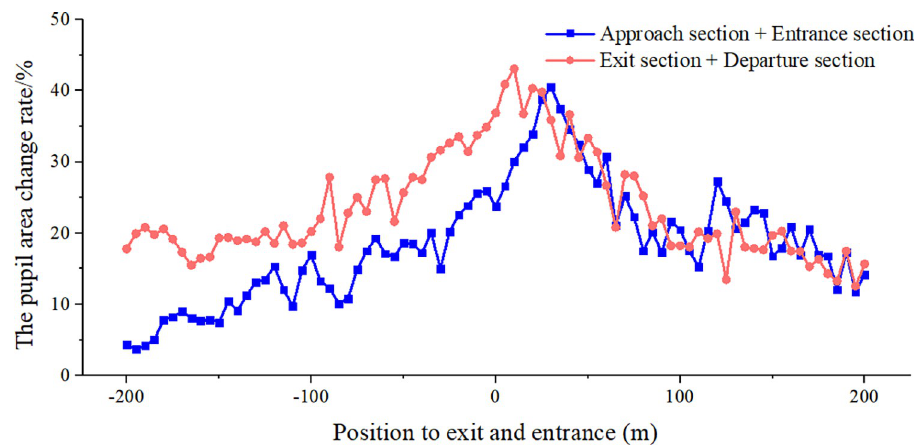
Fig 5. The pupil area change rate at entrance and exit of extra-long expressway